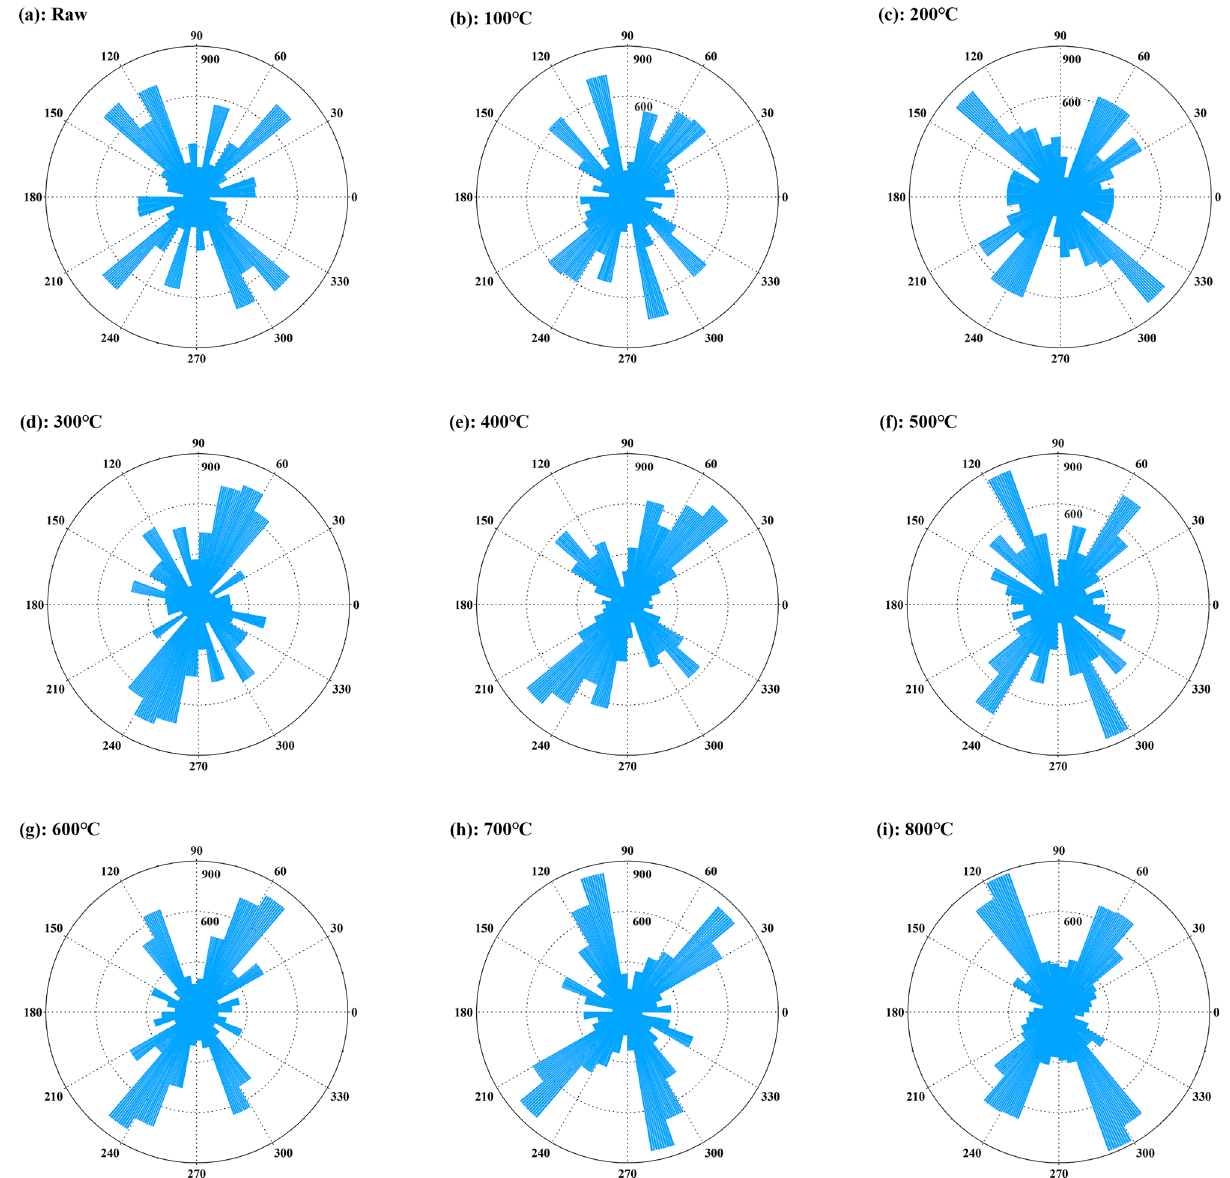
Figure 4. Orientation statistics of the lattice fringe of the heat treatments.